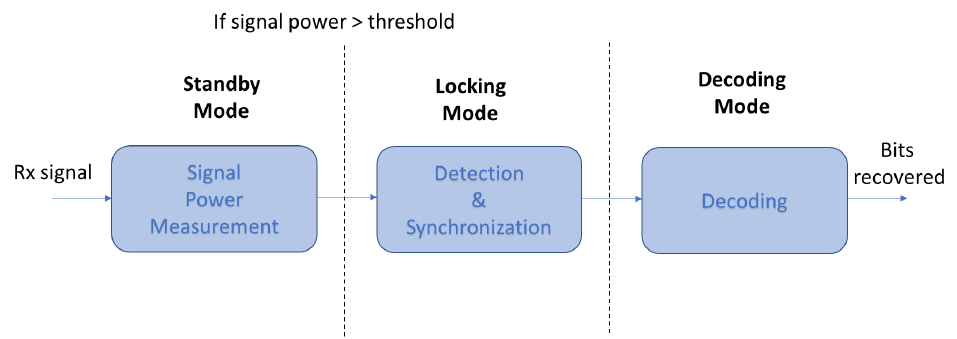
Figure 9. Receiver modes.